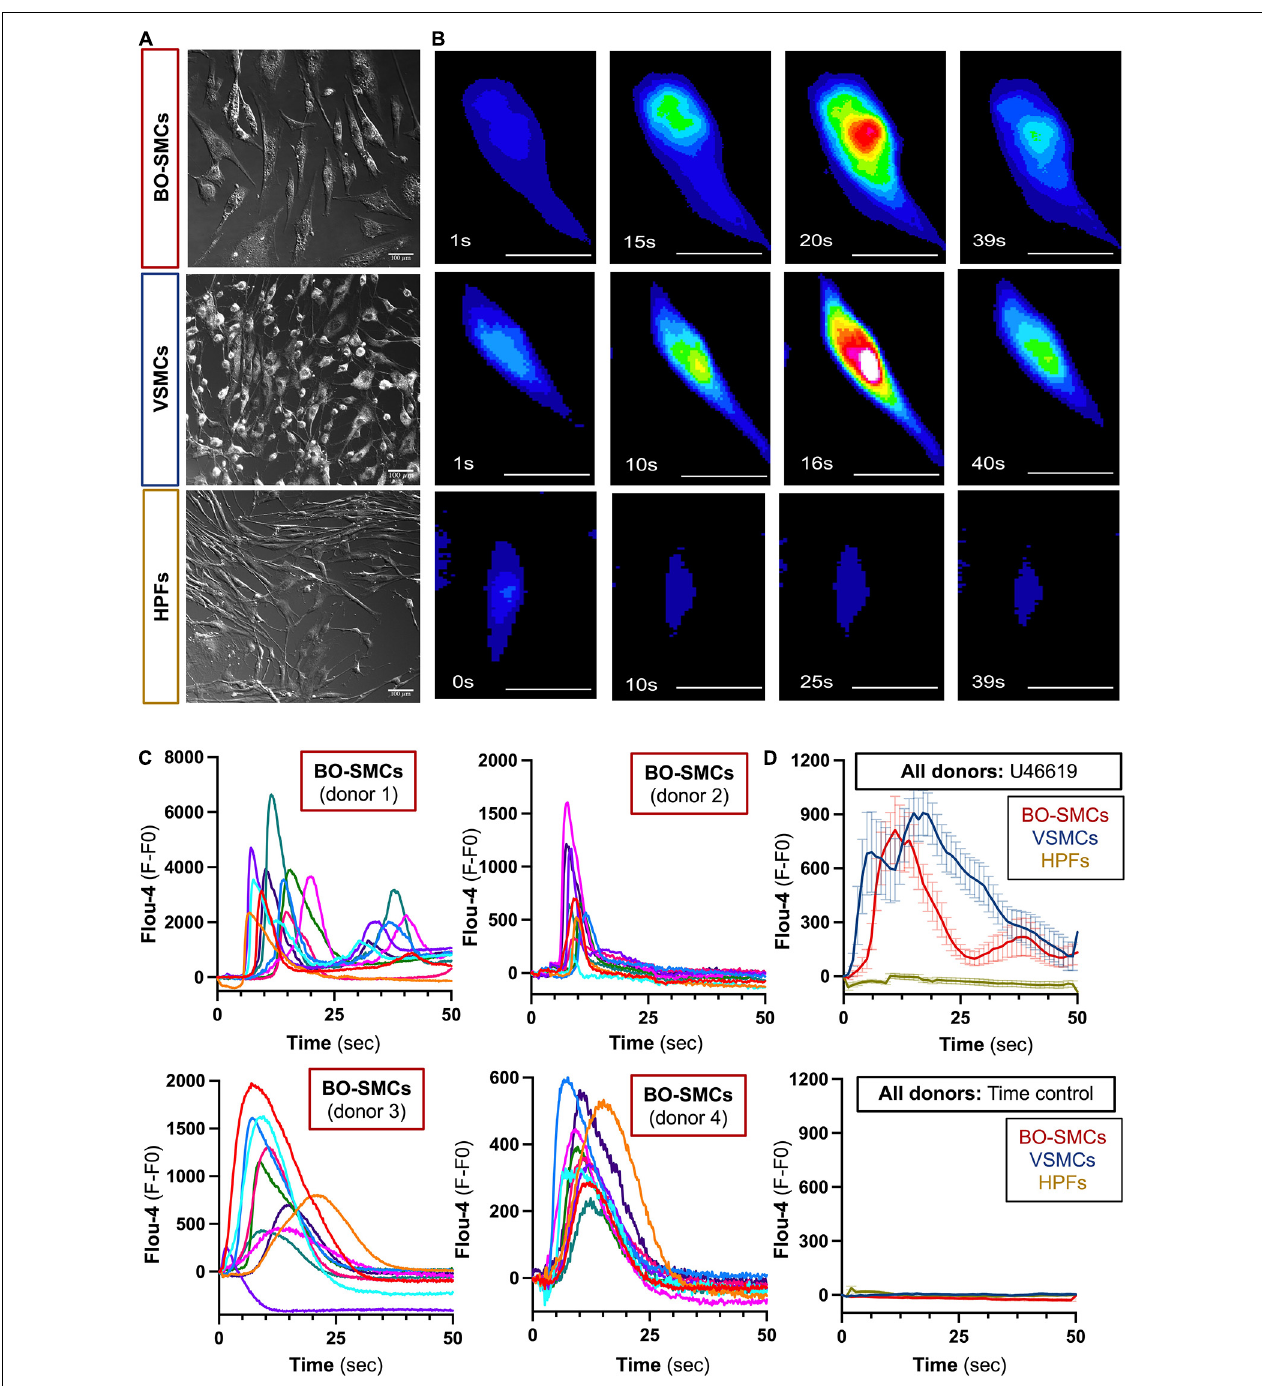
FIGURE 1 | Morphology and comparative calcium responses to U46619 of blood outgrowth smooth muscle cells (BO-SMCs), vascular smooth muscle cells (VSMCs), and fibroblasts (HPFs). Phase contrast images of BO-SMCs, VSMCs, and fibroblasts were obtained using Zeiss Axio Observer WF1 or WF3 microscope at × 20 magnification (A) . Represented fluorescence images of cells stained with Flou-4 treated with U46619 (10 − 6 M) (B) . Fluorescence intensity (fluorescence minus basal fluorescence taken at t = 0; F – F 0 ) tracings from n = 10 individual cells per donor imaged at 5–10 frames/s stained with Flou-4 treated with U46619 (10 − 6 M) (C) . Pooled data showing mean ± SEM for the average intensity tracings obtained following U46619 (10 − 6 M) treatment (BO-SMCs; n = 40 cells comprising 10 individual cells each from four separate donors, VSMCs and HPF; n = 30 cells comprising 10 individual cells from three separate donors) or untreated time controls (BO-SMCs; n = 30 cells comprising 10 individual cells each from three separate donors, VSMCs, and HPF; n = 20 cells comprising 10 individual cells from two separate donors) (D) . Scale bars represent 100 µ m.